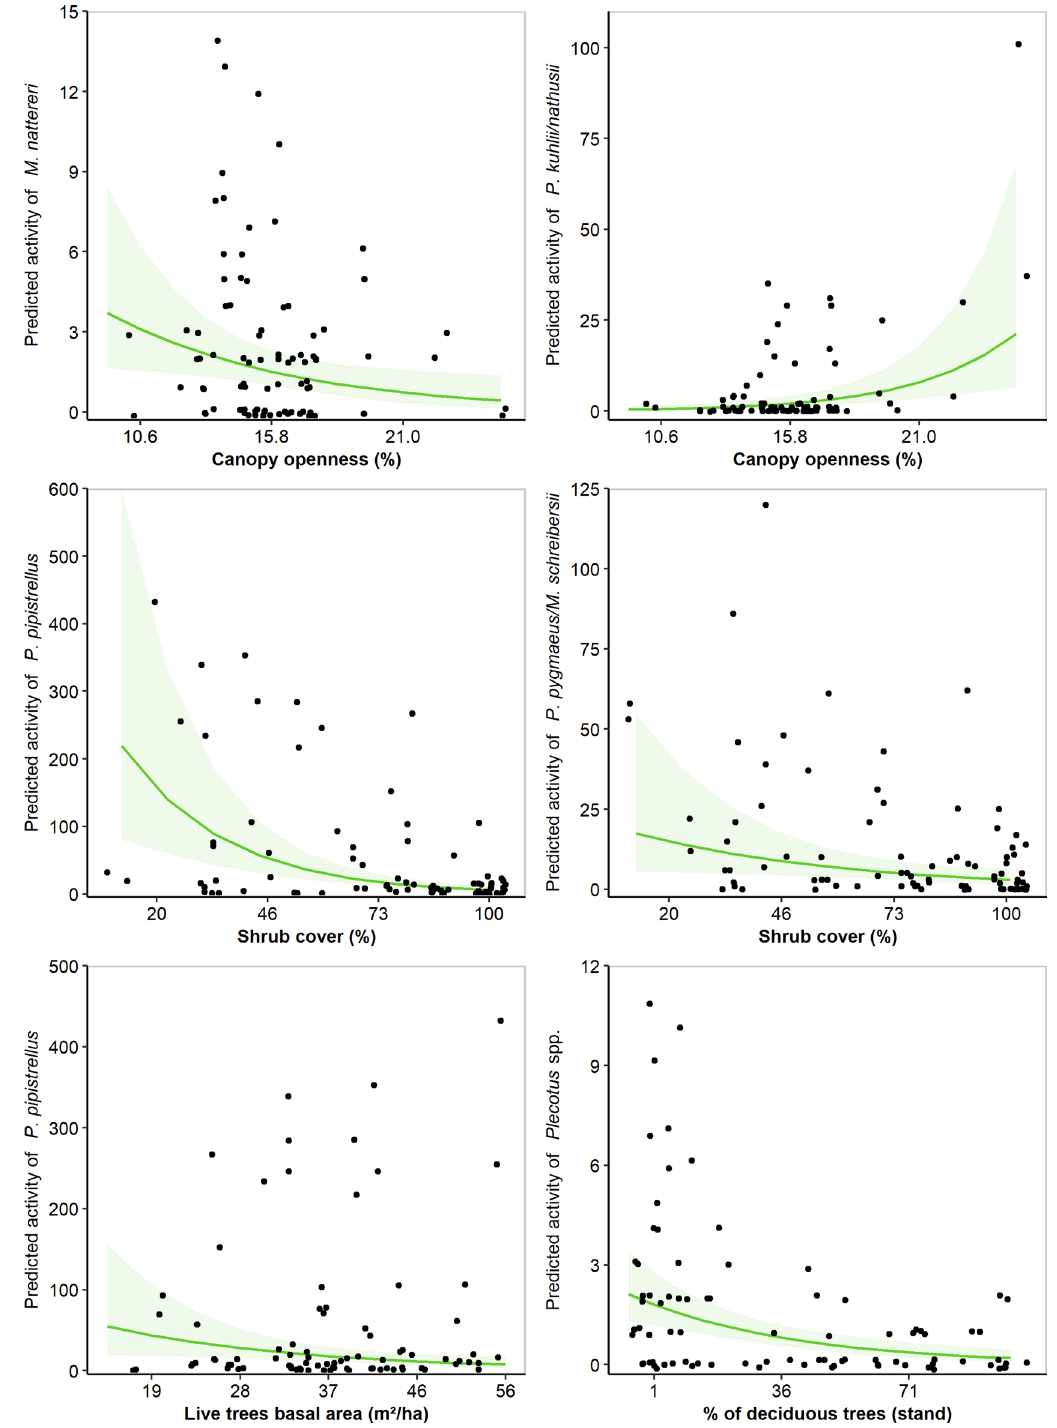
Figure 2. Predicted responses of bats in relation to stand structure and composition. Predictions from GLMMs are represented by the green solid lines with 95% confidence intervals indicated in light green. The raw data are indicated with fill black